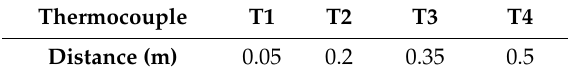
Figure 10. Changes in flue gas temperatures in combustion chamber as a result of decreasing air infiltration intensity (experimental measurements). Table 5. Axial distances of individual thermocouples from the